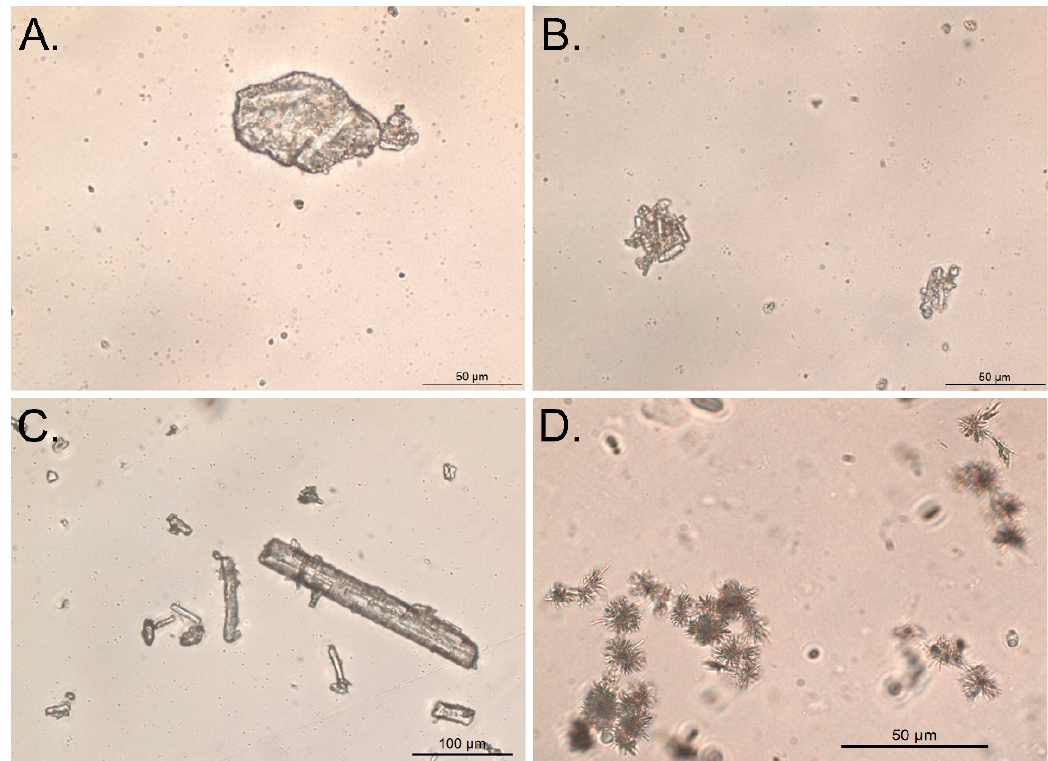
Figure 7. Optic microphotographs of warfarin sodium amorphous API ( A ), warfarin sodium clathrate API ( B ), warfarin API ( C ), and warfarin oral suspension sediment ( D ) particles.